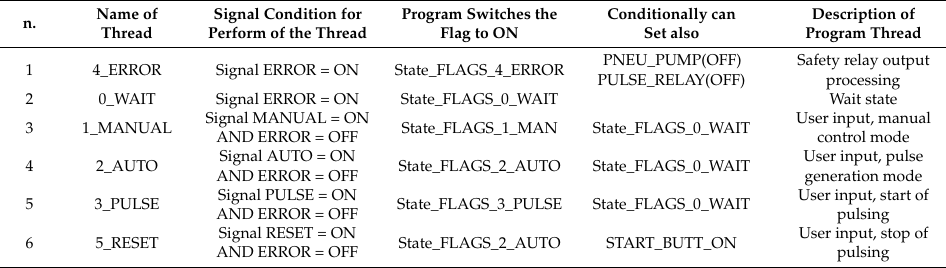
Table 2. List of implemented physical layer threads.